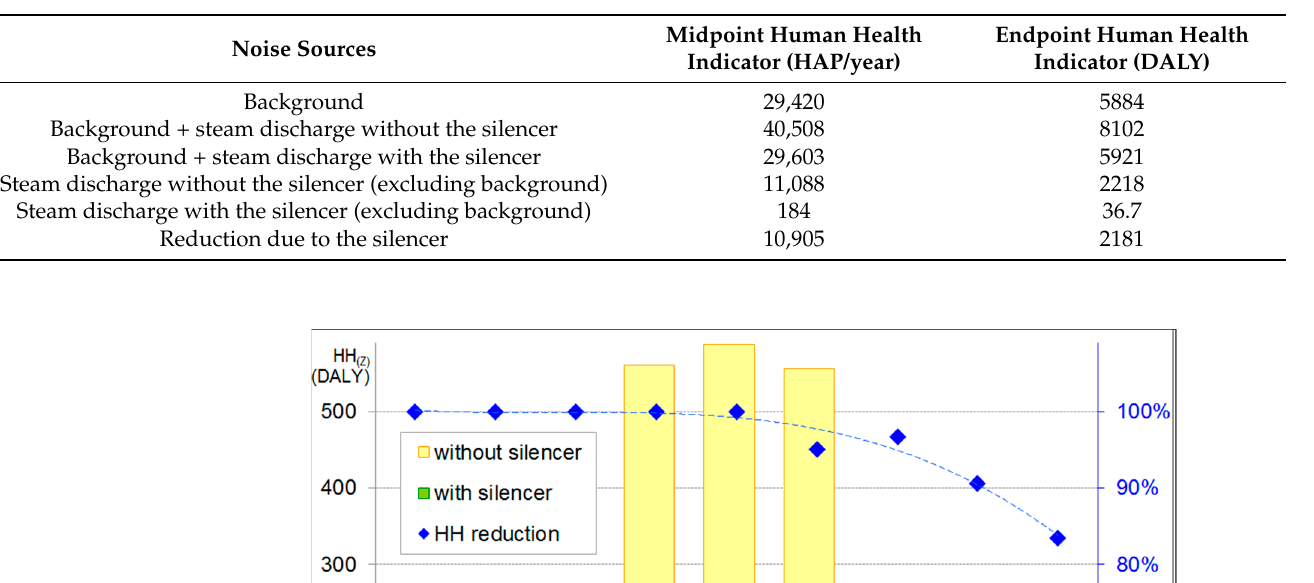
Table 1. Total midpoint and endpoint human health indicators associated with background and steam discharge noise.